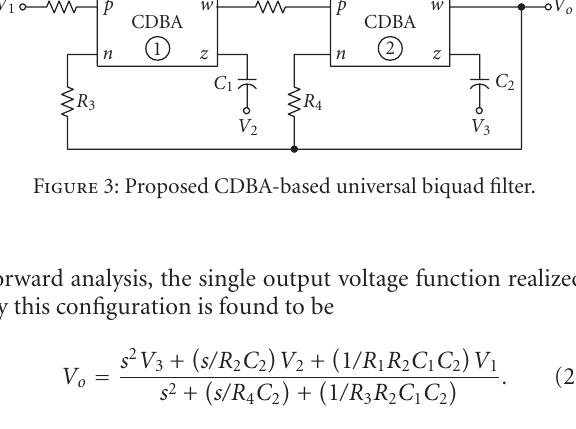
Figure 1: CDBA symbol.